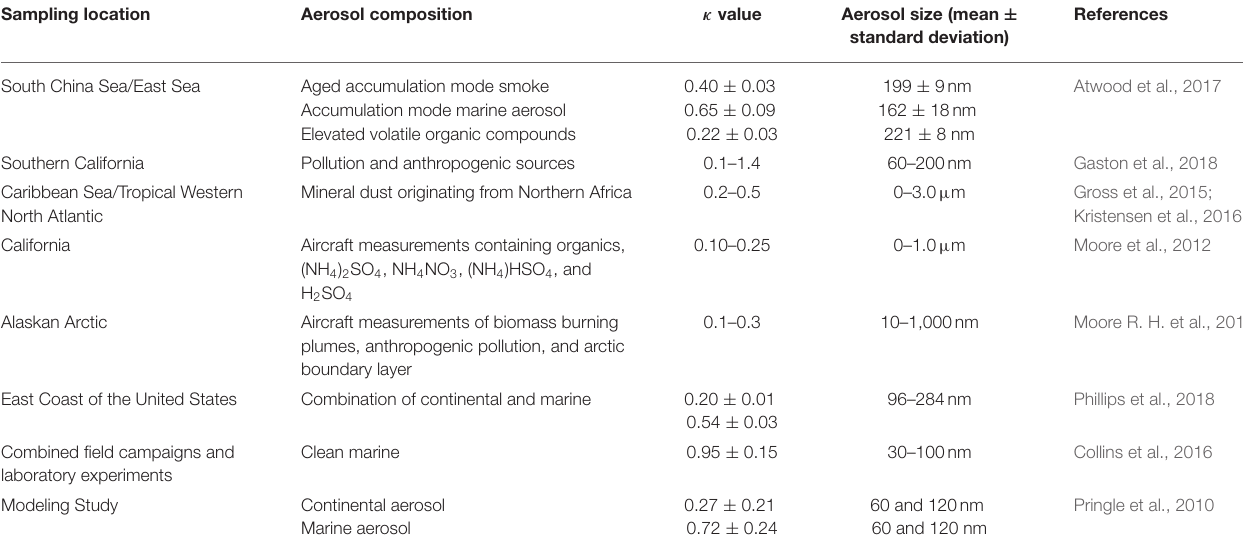
TABLE 1 | Summary of κ